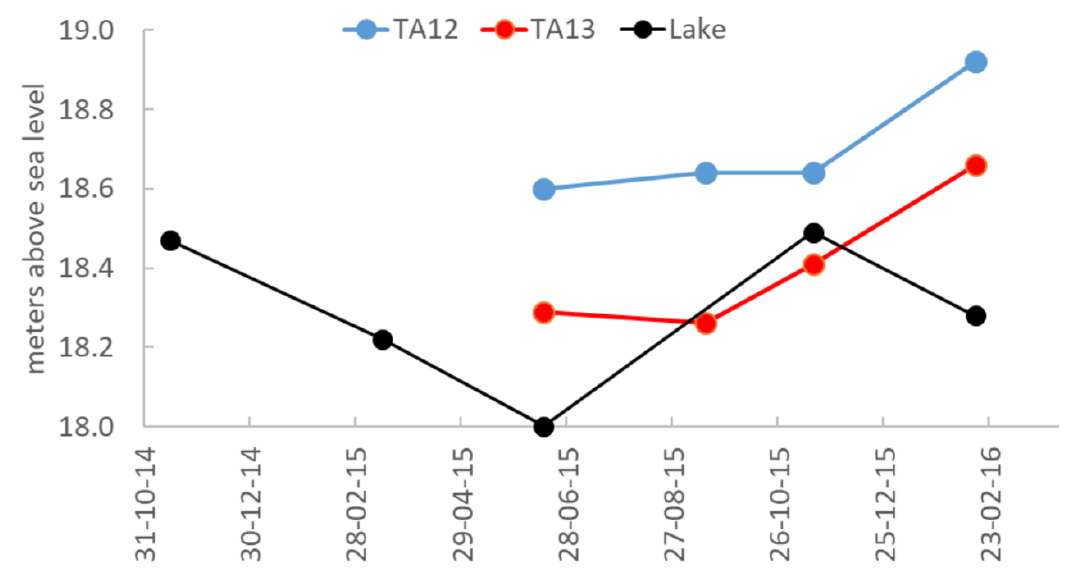
Figure 3. Time series of hydraulic heads in wells TA12, TA13, and lake stage. Only one observation was available for TA18.